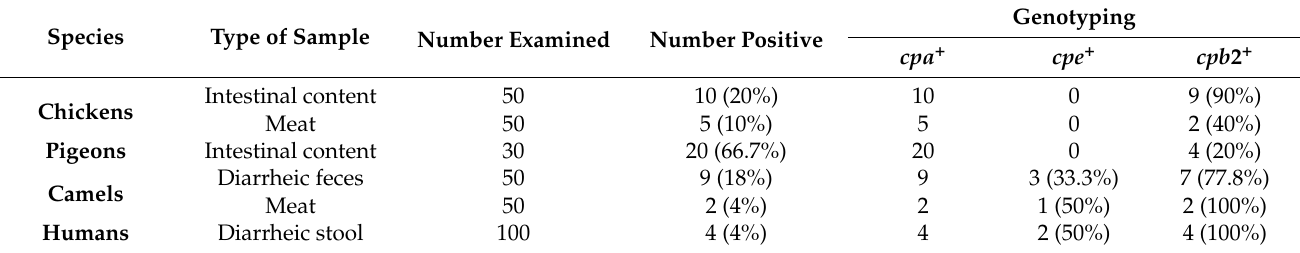
Figure 1. Multifocal pale foci of mucosal necrosis and the lumen of intestine filled with gas bubbles in broiler Hubbard chicken ( A , B ). Jejunum filled with thick, brownish watery exudate in cobb broiler chicken ( C , D ). Table 1. Proportion and count of Clostridium perfringens isolates in chickens, pigeons, camels, and human